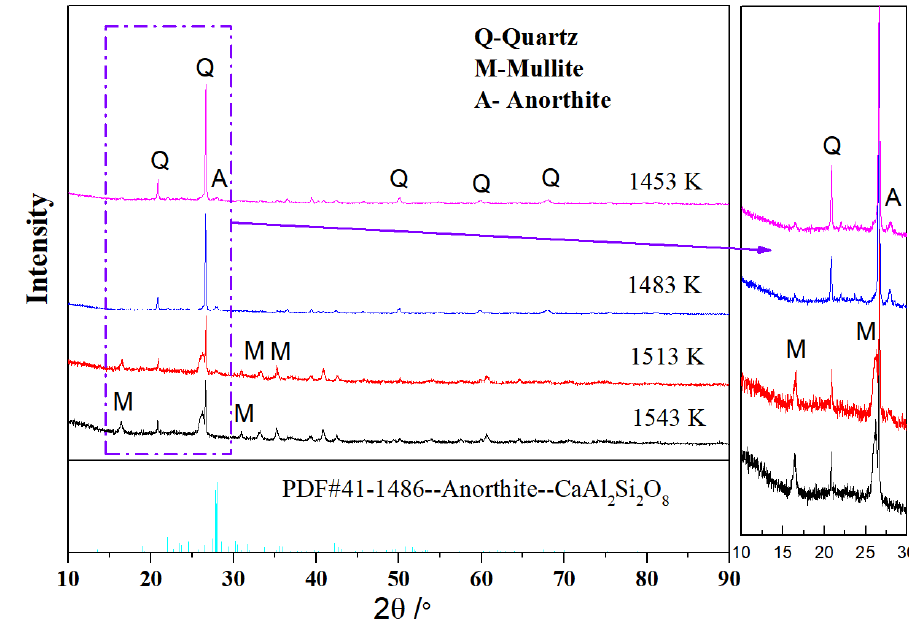
Figure 3. XRD patterns of M at various temperatures. Table 5. Content (wt%) of phase for M at different temperatures.